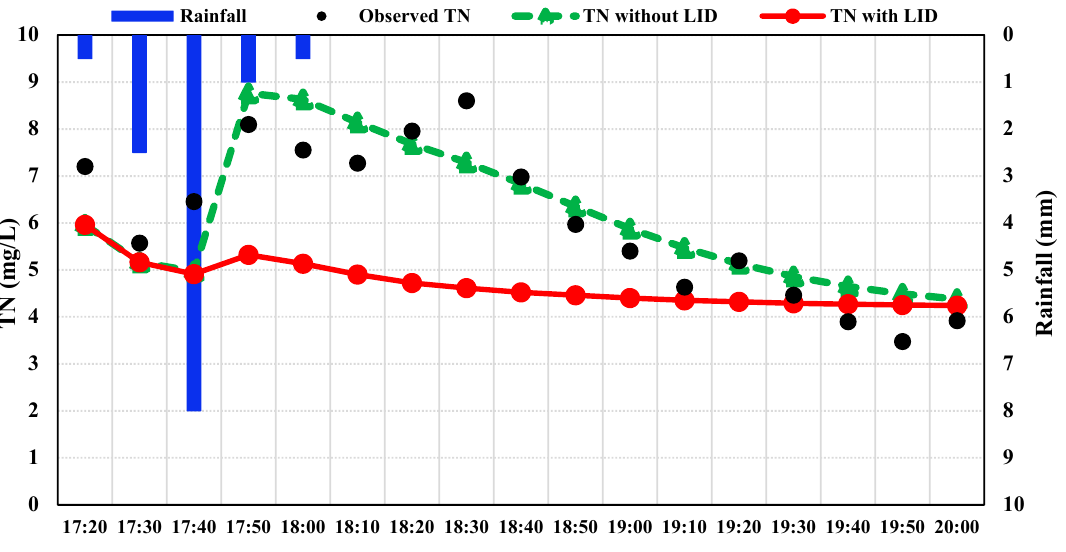
Figure 9. TSS reduction after assigning LIDs to the model.